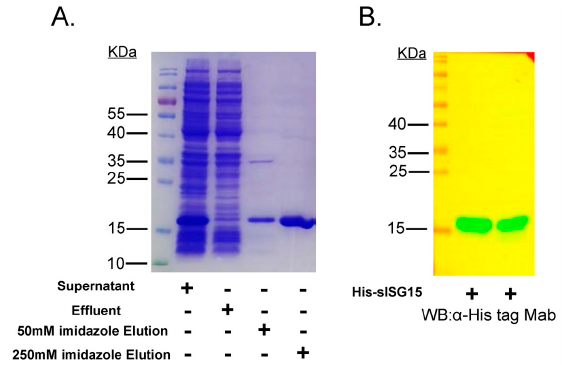
Figure 1. Expression of recombinant swine ISG15 protein (sISG15). ( A ) Supernatant containing soluble 6× His-tagged sISG15 protein after sonication of E. coli or analysis of effluent collected after Ni+ column purification of culture supernatants followed by washing and elution of His-tagged protein using an elution buffer of high imidazole concentration. The eluted protein was subjected to SDS-PAGE for analysis of purity of recombinant expressed sISG15. ( B ) Recombinant expressed sISG15 was subjected to SDS-PAGE and Western blotting using the anti-His-tag Mab to confirm successful expression of His-tagged sISG15.